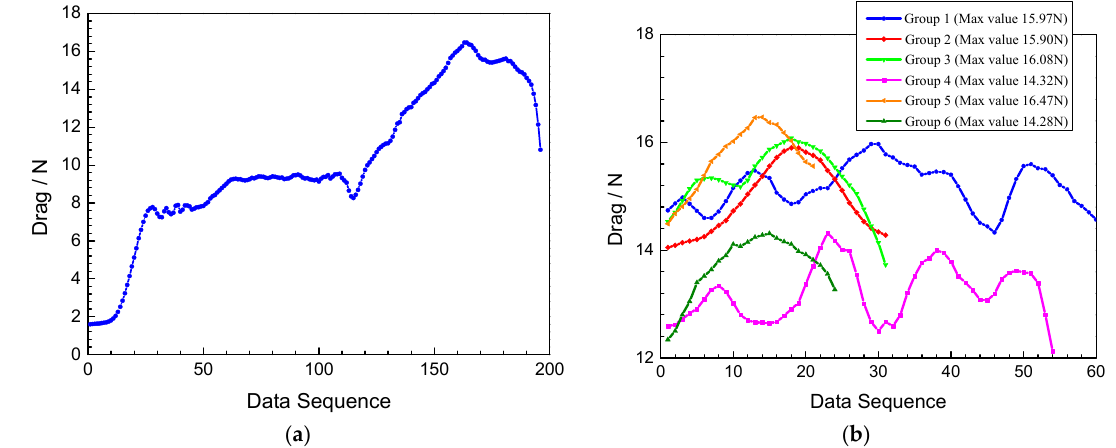
Figure 9. Drag results of the completion string with a packer in the deviated section with a small amount of sand: ( a ) A typical drag curve of the whole moving process; and ( b ) six groups of drag section near the maximum value of the drag curve.